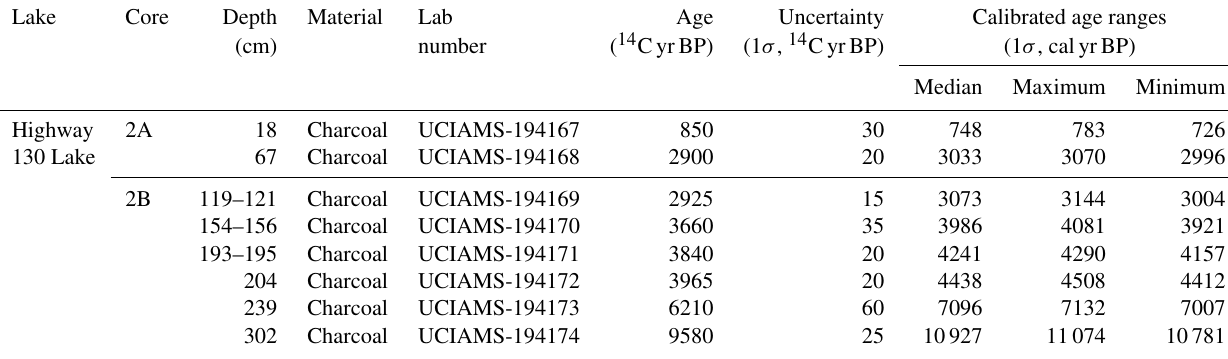
Table 2. Calibrated radiocarbon ages used for the age–depth model.